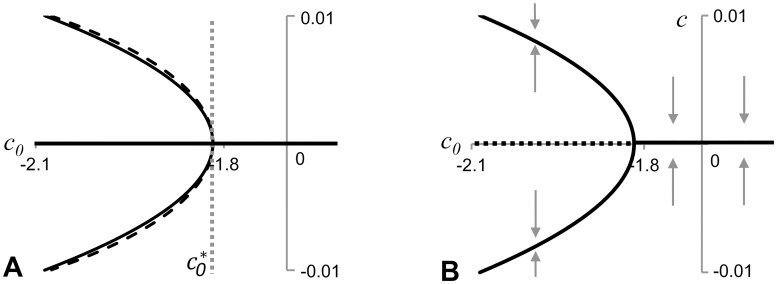
Plots illustrating dependence of the velocity of traveling wave solutions, c, in the system (2, 4), on the strength of chemotaxis, c0, and indicating the presence of a supercritical pitchfork bifurcation in Eq (8).A: Plots of c(c0) satisfying the system (3, 5) for analytical solution (solid black line) and its cubic approximation (dashed line) are shown (for the values of model parameters taken from Fig 3). Plots illustrate that non trivial travelling wave solutions exist below a critical value, c0*, of the bifurcation parameter c0. Travelling solutions emerge in pairs, moving with an equal speed in the opposite directions. B: Our stability analysis indicates that the pitchfork bifurcation is supercritical and solutions corresponding to travelling waves are stable.